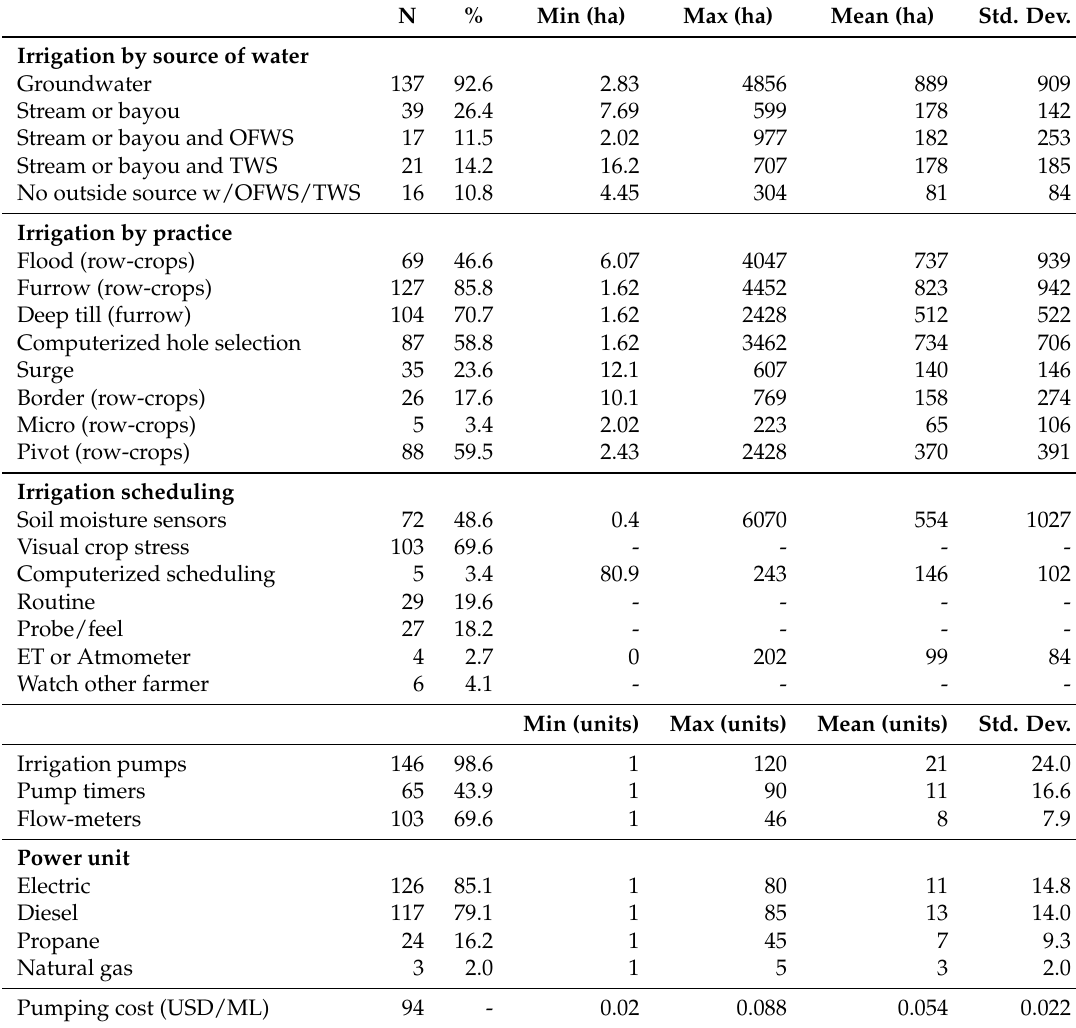
Table 3. Summary statistics of irrigation